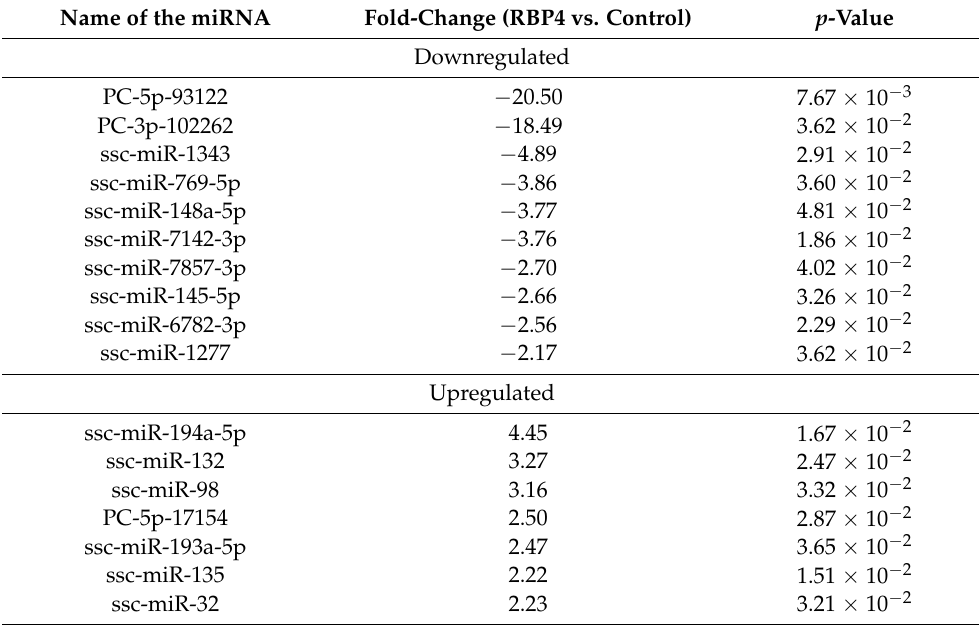
Table 2. Significant DEmiRNAs ( p < 0.05).